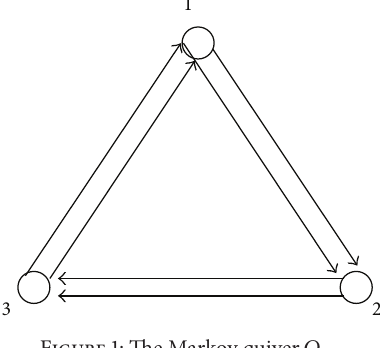
Figure 1: The Markov quiver 𝑄 1,1